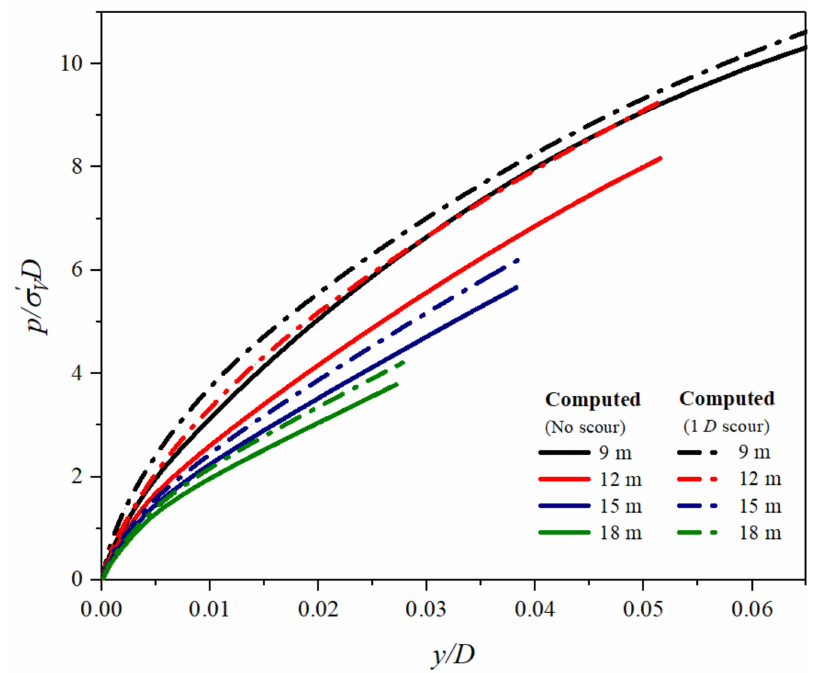
Figure 6. Load displacement characteristics of piles at different depths in S d 1 = 1 D ( 6 m )